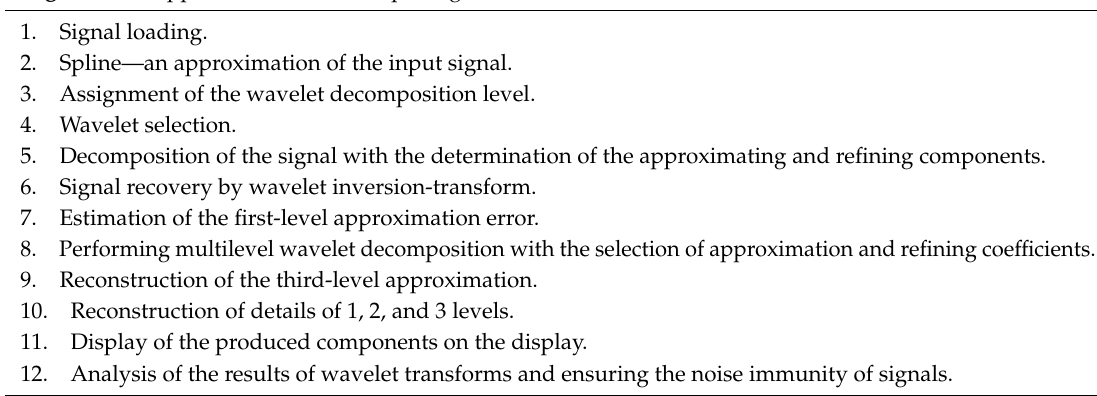
Algorithm 1 Approximation of the Input